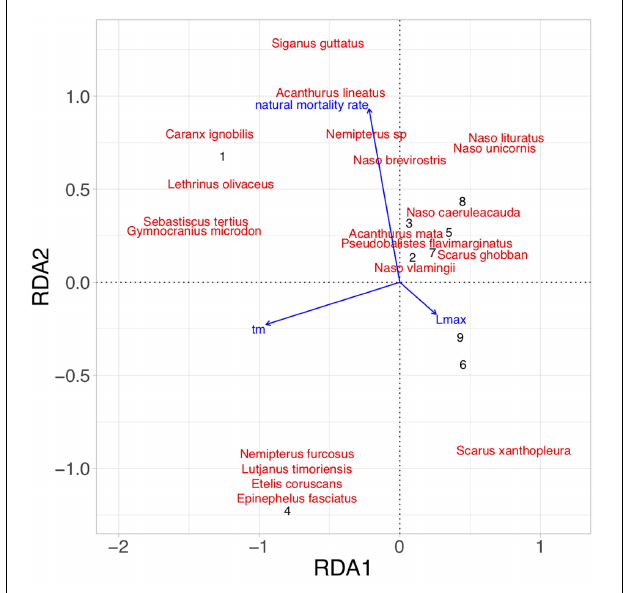
FIGURE 5 | Redundancy analysis (RDA) of fishing grounds with life-history characteristics as explanatory variables of fish species biomass. Numbers 1 through 4 represent unique fishing ground-handline combinations, whereas numbers 5 through 9 represent unique fishing ground-speargun combinations (see Table 2 ). Life-history characteristics include age at first maturity (years; tm), natural mortality rate, and maximum length (cm; L max